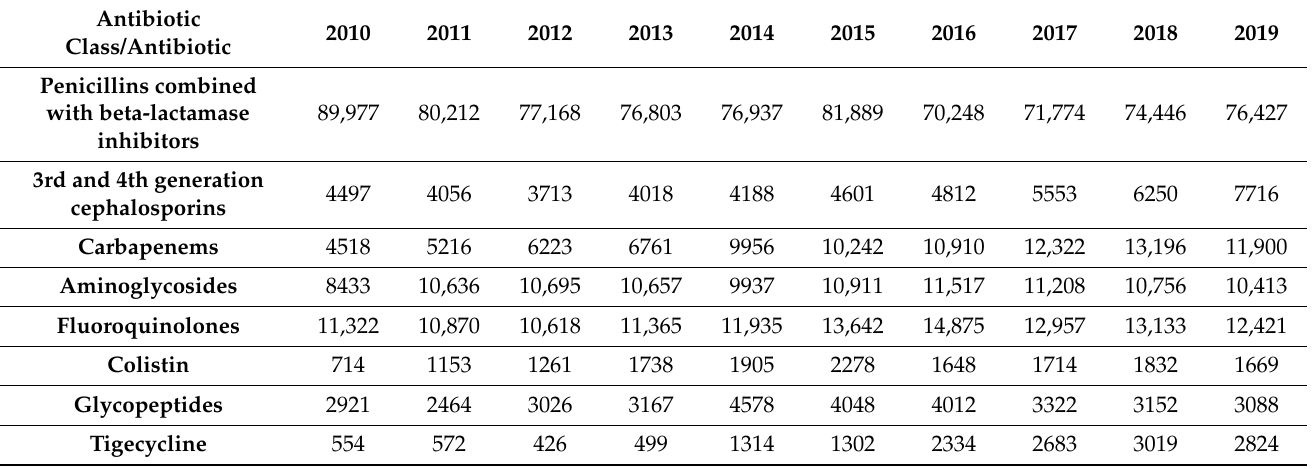
Consumption of antibiotics or antibiotic classes at the University Hospital Olomouc is shown in Table 7. The data indicate increasing consumption of carbapenems (r = 0.964), tigecycline (r = 0.879), third- and fourth-generation cephalosporins (r = 0.867) and flu- oroquinolones (r = 0.733). Conversely, consumption of penicillins combined with beta- lactamase inhibitors decreased (r = − 0.745). Analysis of the relationship between antibiotic consumption and resistance in the entire hospital showed significant correlations between aminoglycoside consumption and resistance of Escherichia coli to gentamicin (r = 0.712), fluo- roquinolone consumption and resistance of Klebsiella pneumoniae to ciprofloxacin (r = 0.896) and aminoglycoside consumption and resistance of Pseudomonas aeruginosa to amikacin (r = 0.716) (Figures 1–3). Table 7. Antibiotic consumption in defined daily doses (DDDs) at the University Hospital Olomouc. Antibiotic Class/Antibiotic with beta-lactamase inhibitors